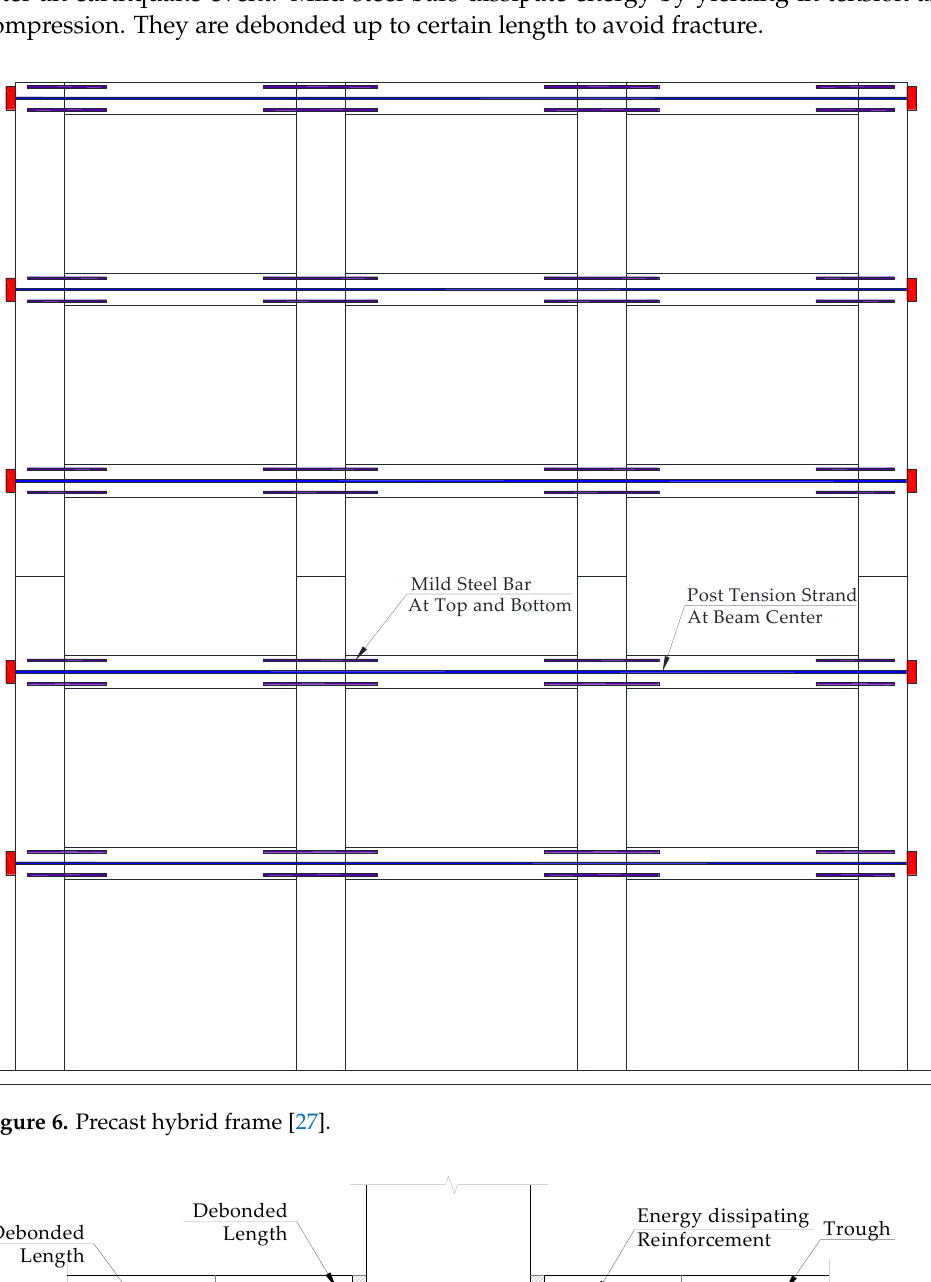
Mild Steel Bar CenterMild Steel Bar At Top and Bottom At Top and Bottom